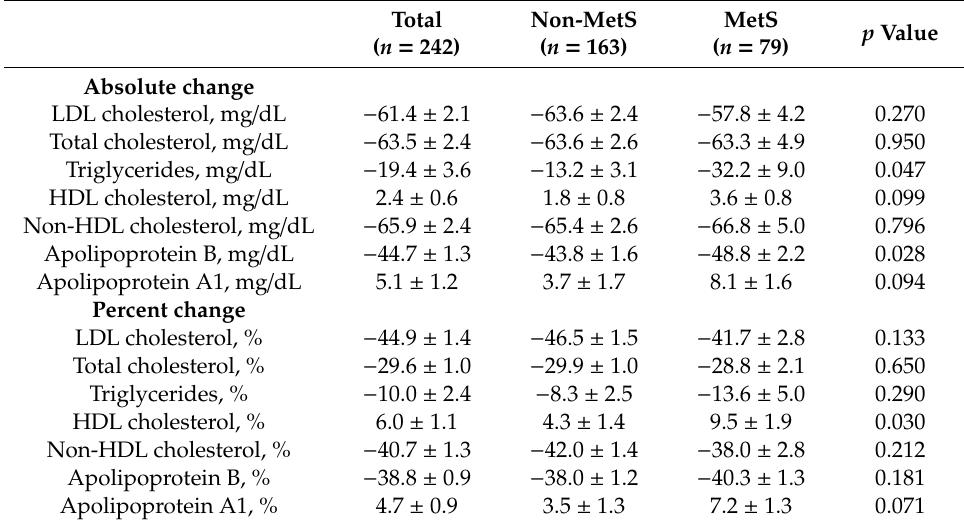
Table 6. Percentage changes in lipid profiles by metabolic